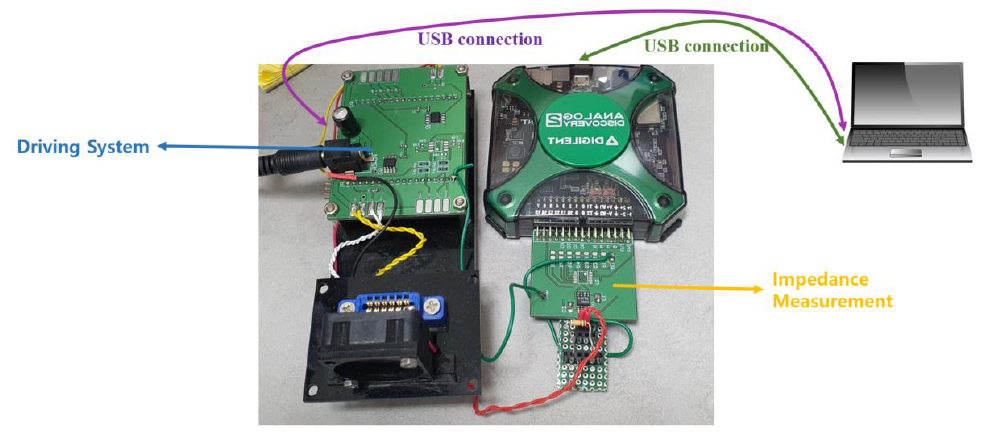
Figure 5. Driving and detection system used in the experiment.